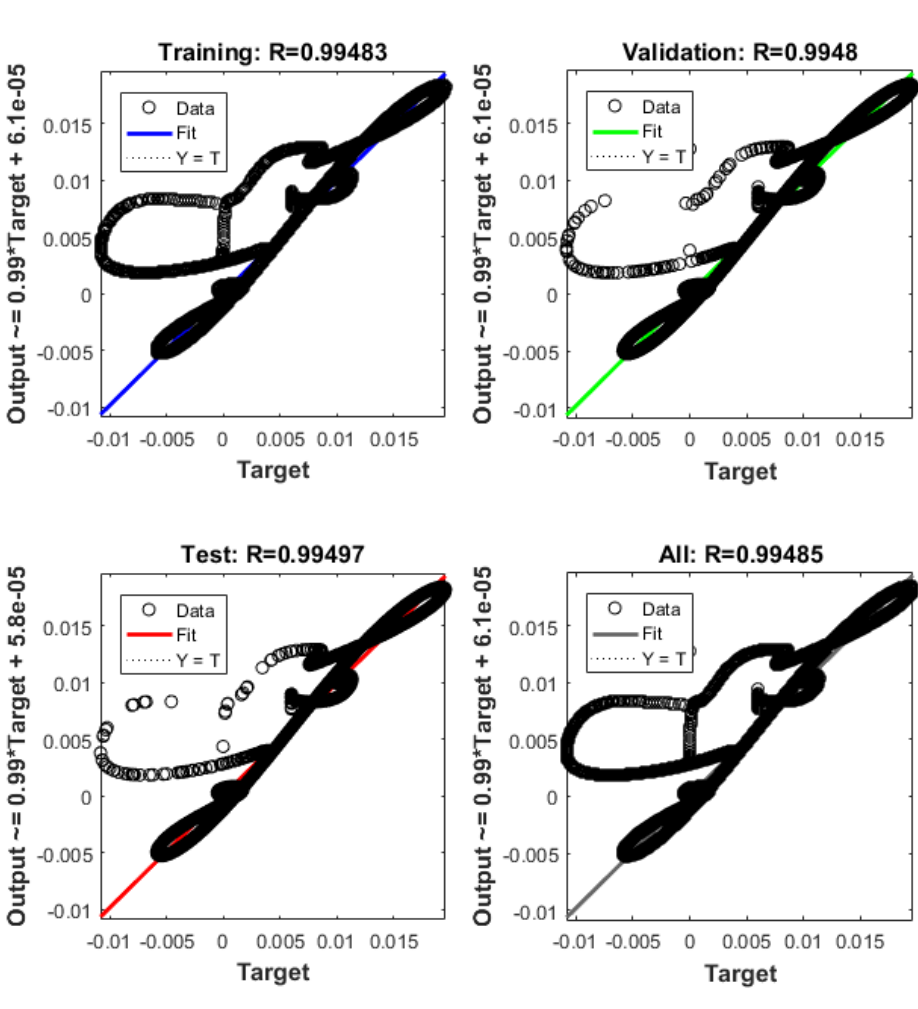
Figure 24. ANN regression plot, equilibrium at x = 0.01 m.